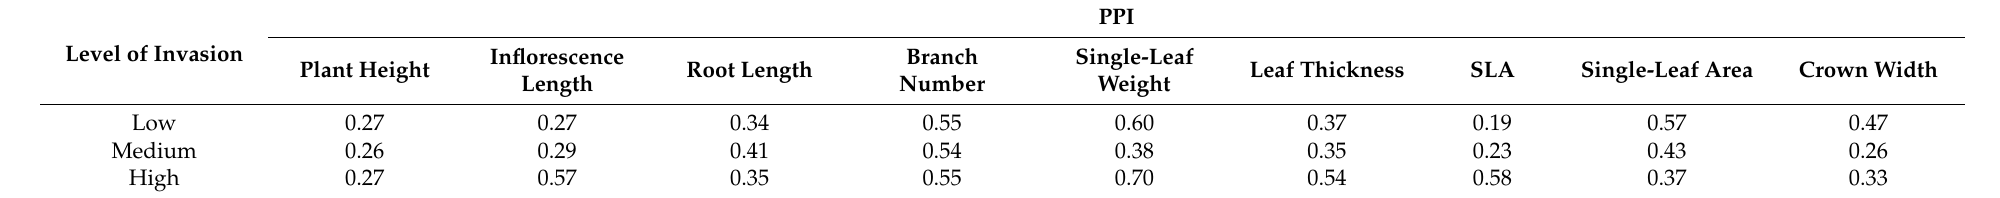
Table 2. Plasticity of morphological characteristics of Pedicularis kansuensis in different invasion